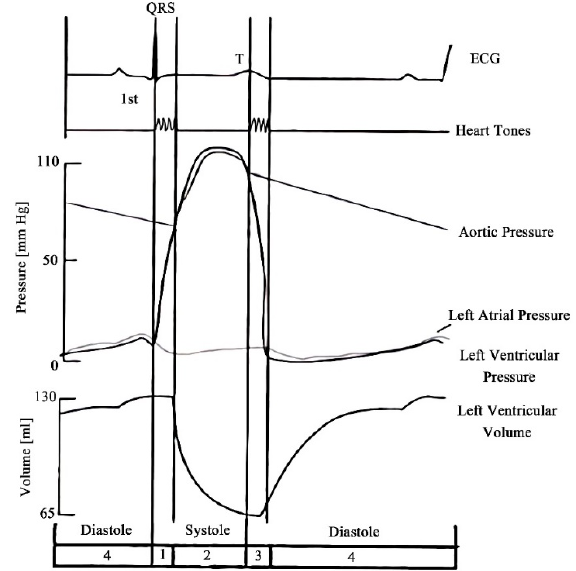
Figure 2. Volume changes during a